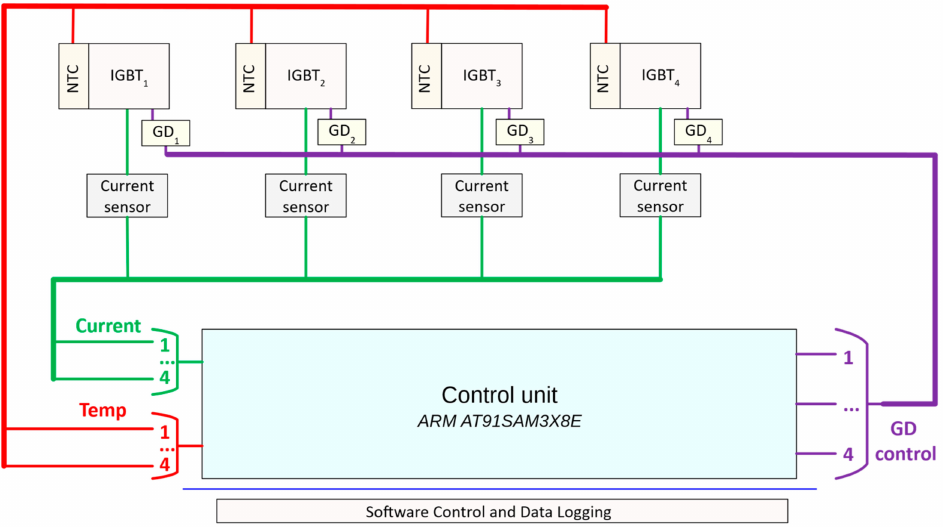
Figure 1. Test model control